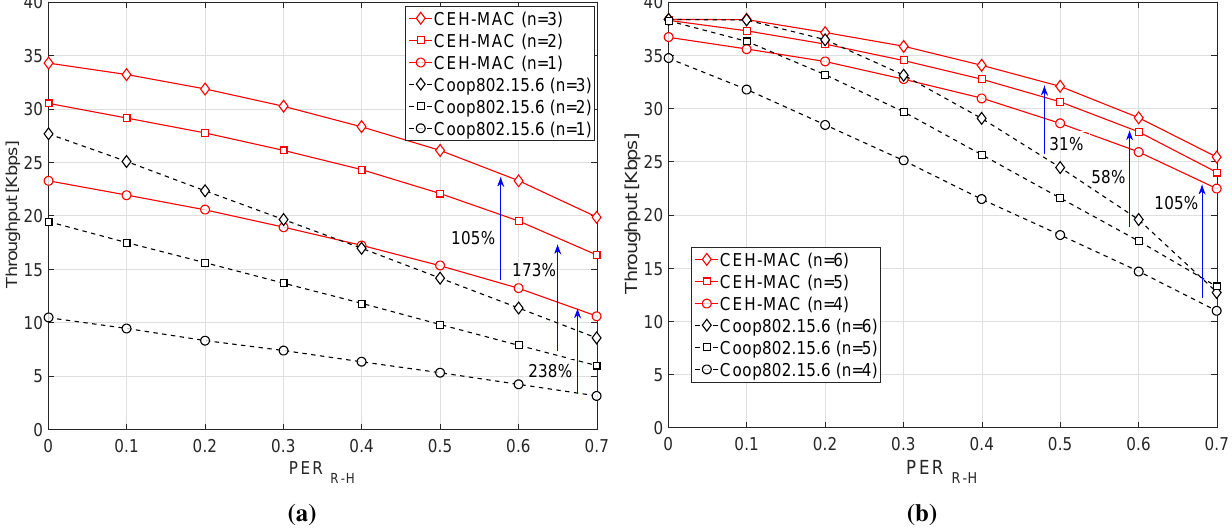
Figure 6. Throughput performance. ( a ) n = 1 , 2 , 3 relays; ( b ) n = 4 , 5 , 6